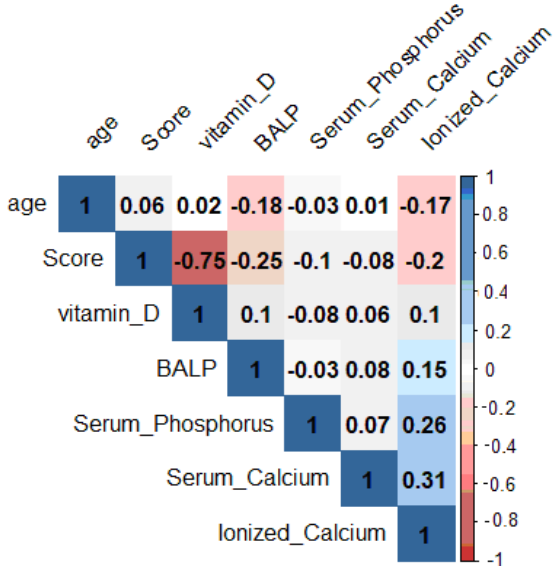
Figure 2. Evaluation of the correlation coefficients of the parameters taken into consideration. The study of the relationship between score and 25OHD showed a straight line representing the linear link between the two variables, decreasing with increasing 25OHD (Figure 3a). Therefore, this data confirms a linear correlation coefficient equal to − 0.75 between 25OHD and score.